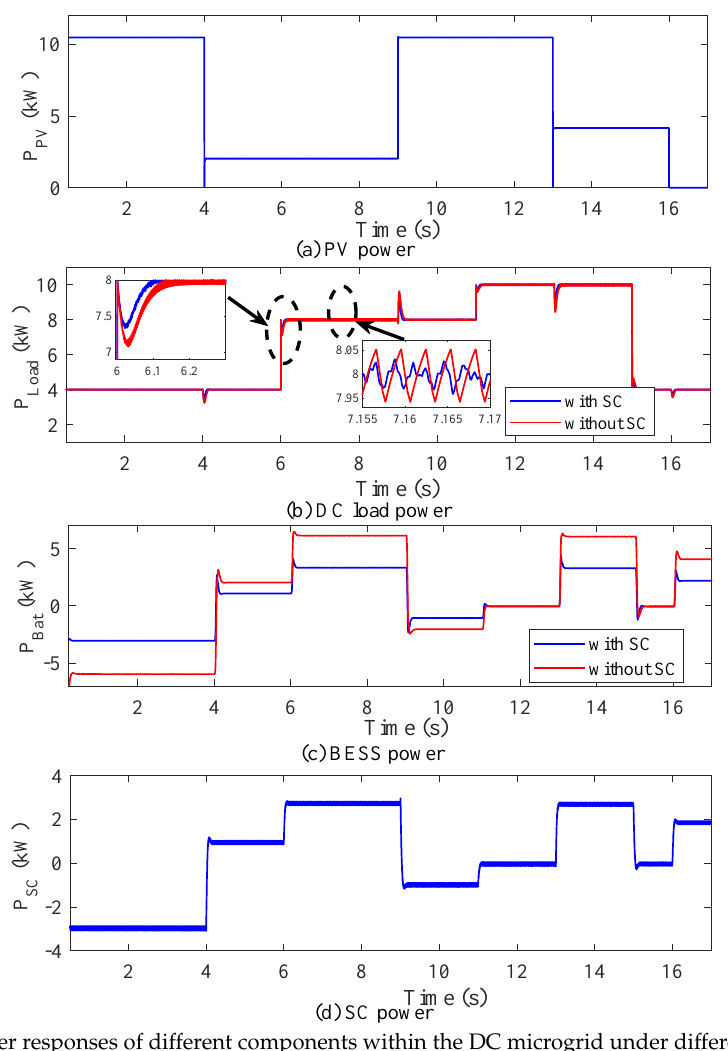
Figure 6. Power responses of different components within the DC microgrid under different operating conditions considering step changes in the solar irradiation.